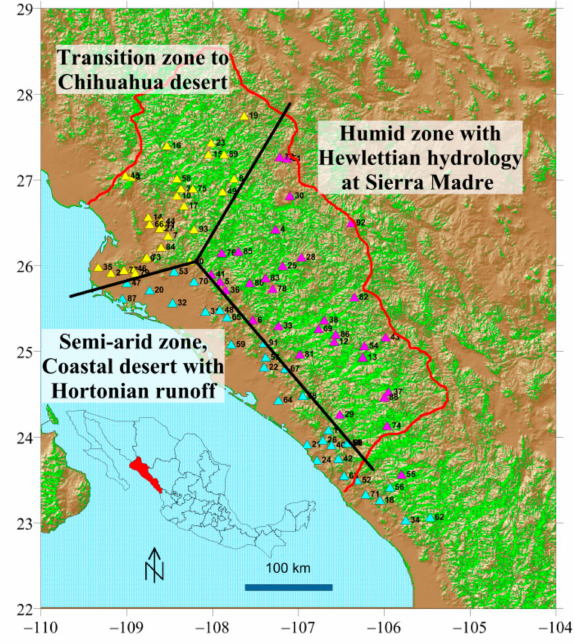
Figure 2. Regionalization proposed using Equation (8).